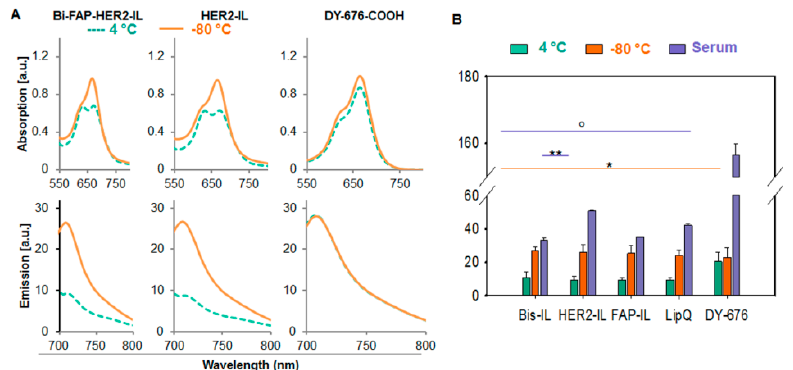
Figure 2. Validation of liposome quenching and activatability by spectroscopic measures. ( A ) The spectra of 200 nmol (final lipids) of the liposomes show double absorption maxima and low fluorescence emission when intact (green broken lines) and a single absorption maximum and increased fluorescence emission after freeze damage (orange lines). Contrarily, the free DY676-COOH measured at a concentration equivalent to the dye content in 200 nmol LipQ, shows only a single absorption peak and high fluorescence emission independent of the storage condition at 4 or − 80 °C. ( B ) Semiquantitative levels of fluorescence emitted by intact (4 °C, green bars) and freeze-damaged liposomes ( − 80 °C, orange bars) reveal an almost 3-fold increase in liposomal fluorescence upon activation. Incubation with serum leads to a 3–4-fold increase in liposomal fluorescence (relative to the level of intact liposomes in buffer), and a 6-fold increase in fluorescence of the free DY676-COOH (relative to the level of the dye in buffer). Each bar depicts the mean of three independent (for 4 and − 80 °C) or two measurements (serum) and the standard deviations. * p < 0.001 for freeze-damaged versus intact liposomes, ** p < 0.05 for HER2-IL in serum versus Bis-IL or FAP-IL in serum, ° p < 0.001 for DY676-COOH in serum versus all intact liposomes and liposomes in serum.